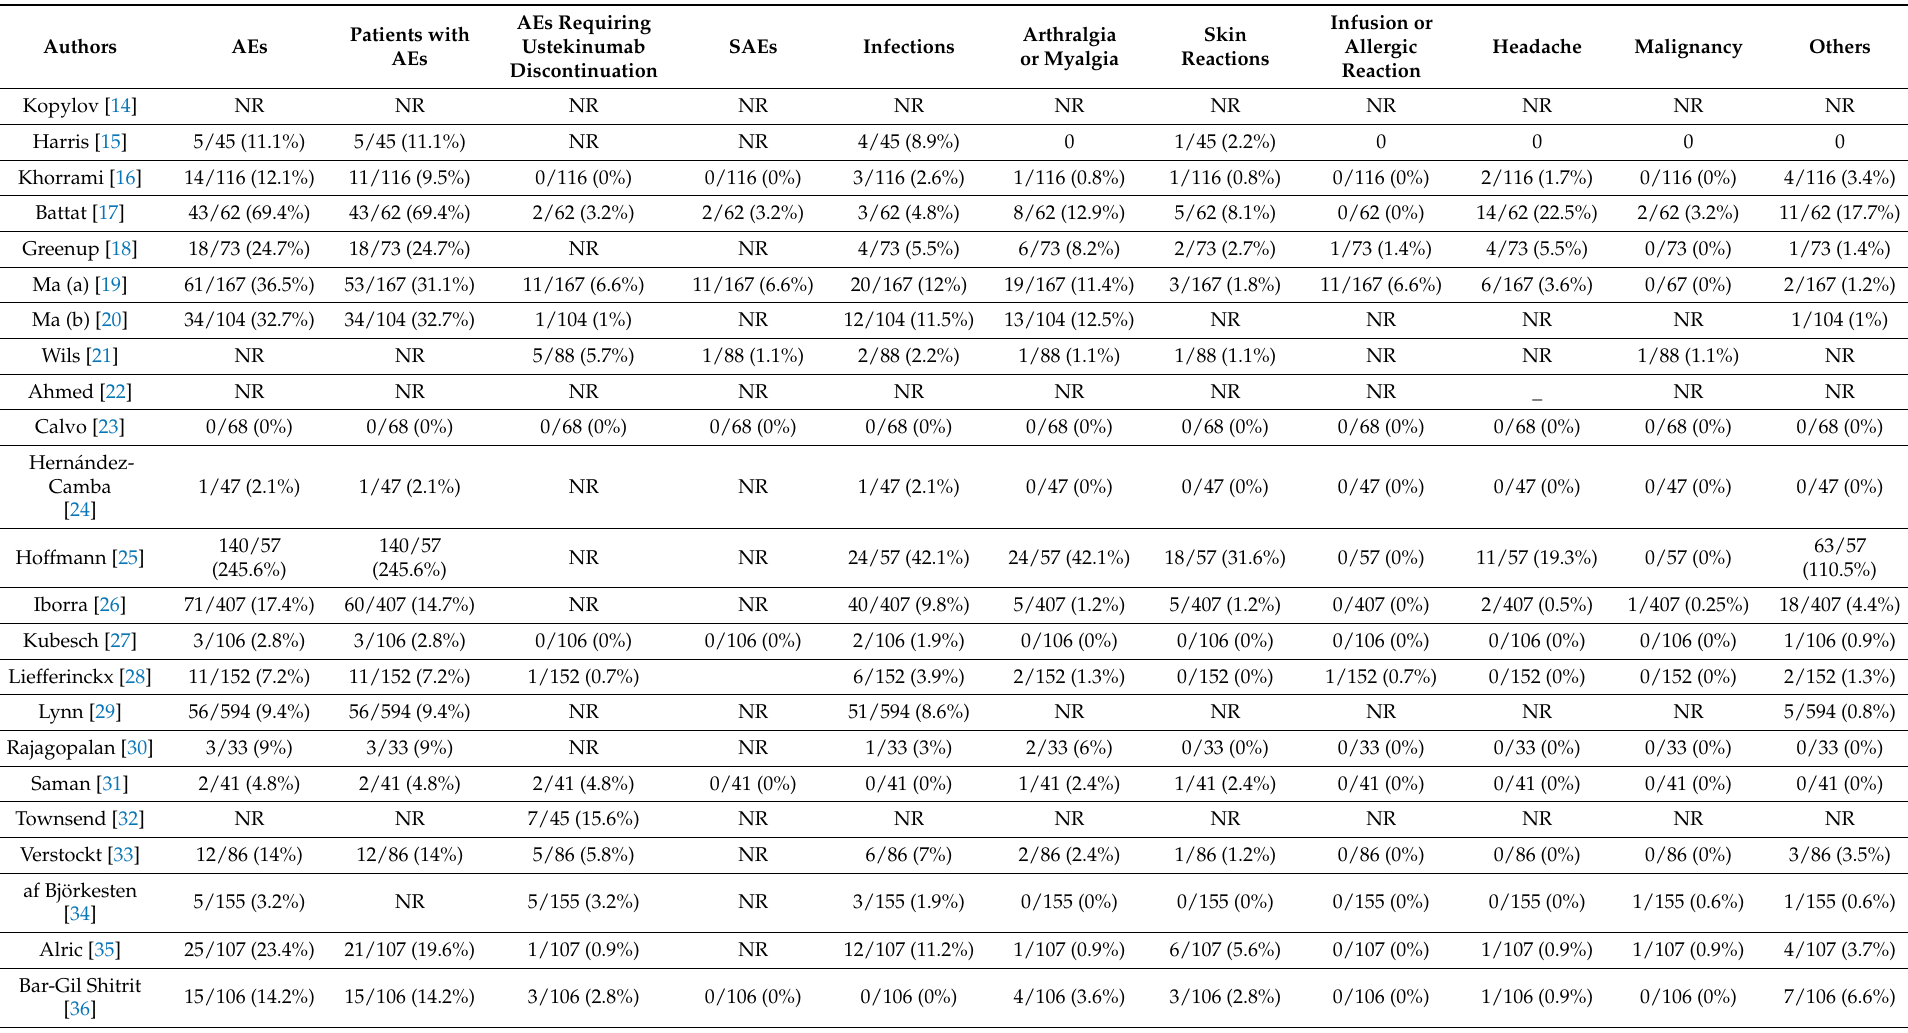
Table 4. Safety of